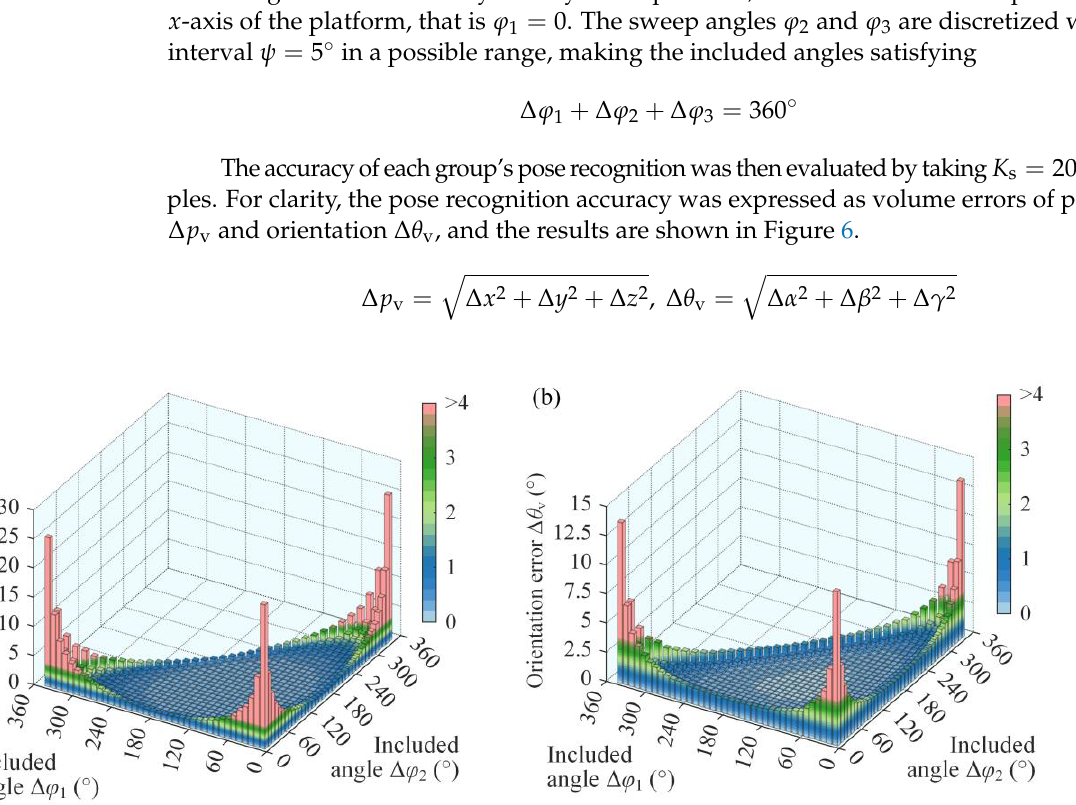
Figure 7. Recognitions errors of sorted marker groups, with position error in blue color and orien- tation error in pink color.